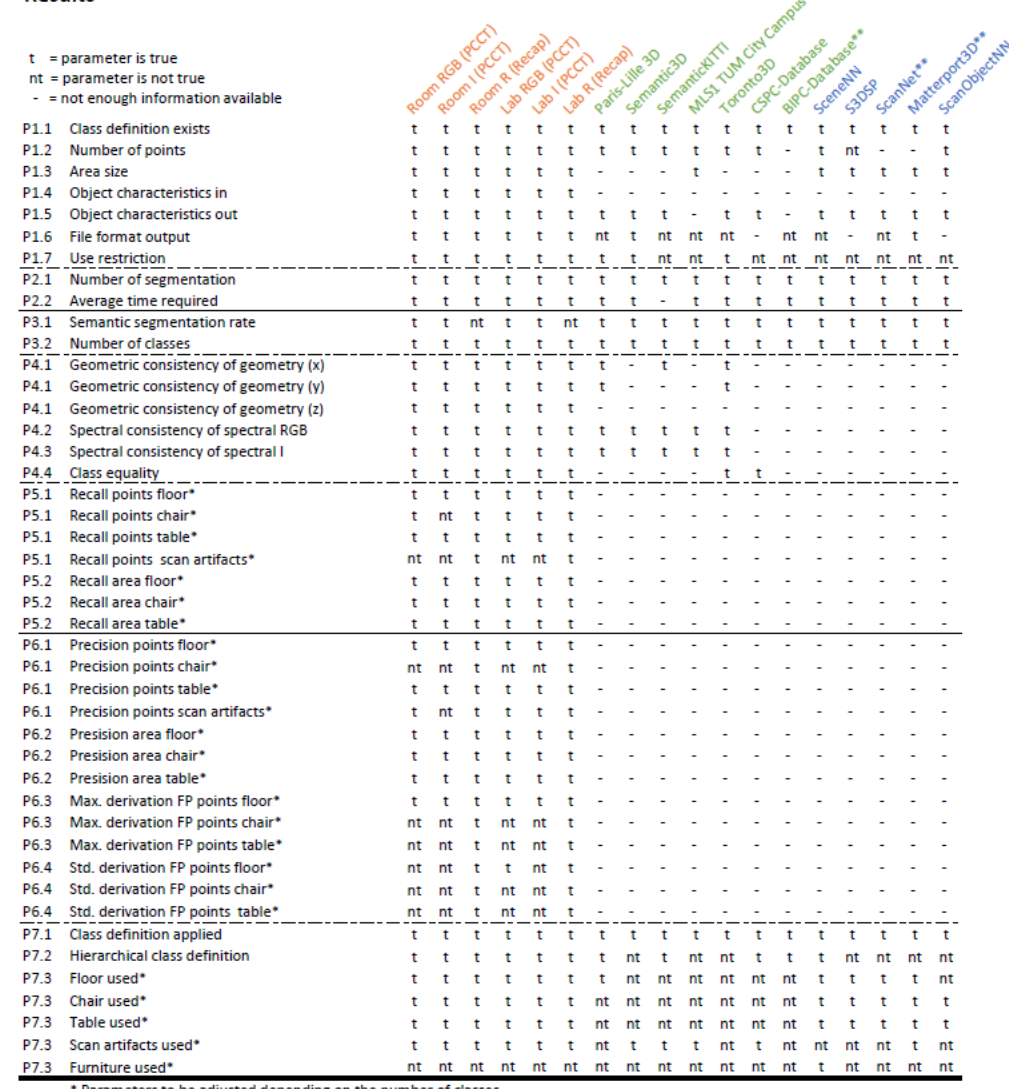
Figure A1. Point cloud dataset comparison. Example: Point cloud as